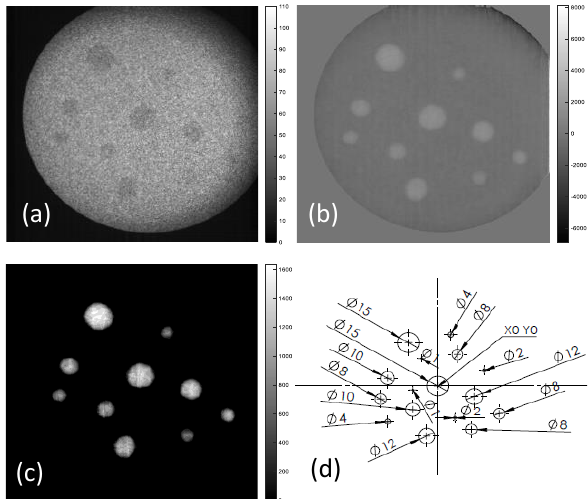
Fig. 7. The detection of a lower detectability limit using polydisperse steel ball phantoms, including (a) an unprocessed X-ray image of the phantom, (b) a denoised, log-flat field normalized and inverted image, (c) a segmented image showing the detected steel balls, and (d) a schematic of the steel ball sizes and